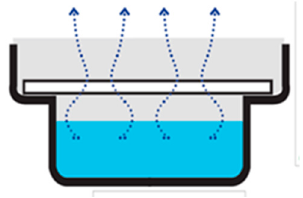
Figure 1. Diagram of water vapor diffusion [13].